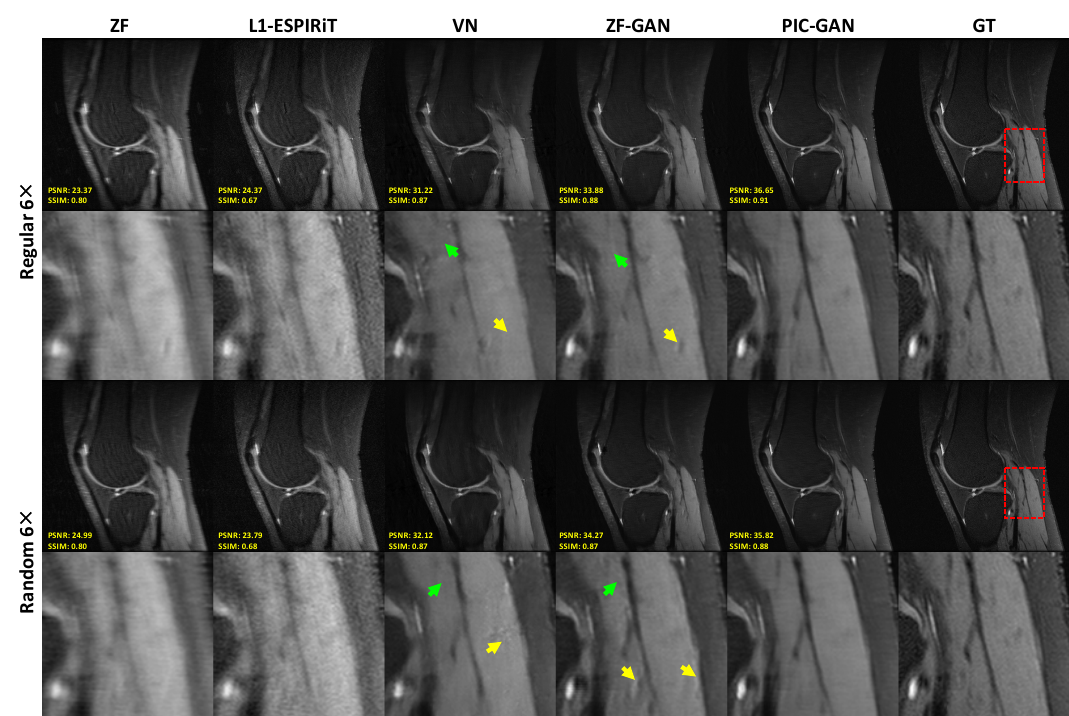
Figure 6. Representative knee images reconstructed with an acceleration factor of 6. The first and second rows show reconstruction results using regular Cartesian sampling, the third and fourth rows show reconstruction results using variable density random sampling. Zoomed in views (as red boxes) show that the proposed method has resulted in both sharper and cleaner reconstruction compared to the results obtained by L1-ESPIRiT, VN and ZF-GAN. Both ZF-GAN and PIC-GAN reconstruction can significantly suppress the artifacts compared to ZF and L1-ESPIRiT. (GT: Ground truth. ZF: Zero-filled. L1-ESPIRiT: Sparsity-based parallel imaging. VN: Variational network. ZF-GAN: Conventional GAN with single-channel images as input PIC-GAN: Our proposed method. ZF-GAN images contained blurred vessels (green arrows) and blocky patterns (yellow